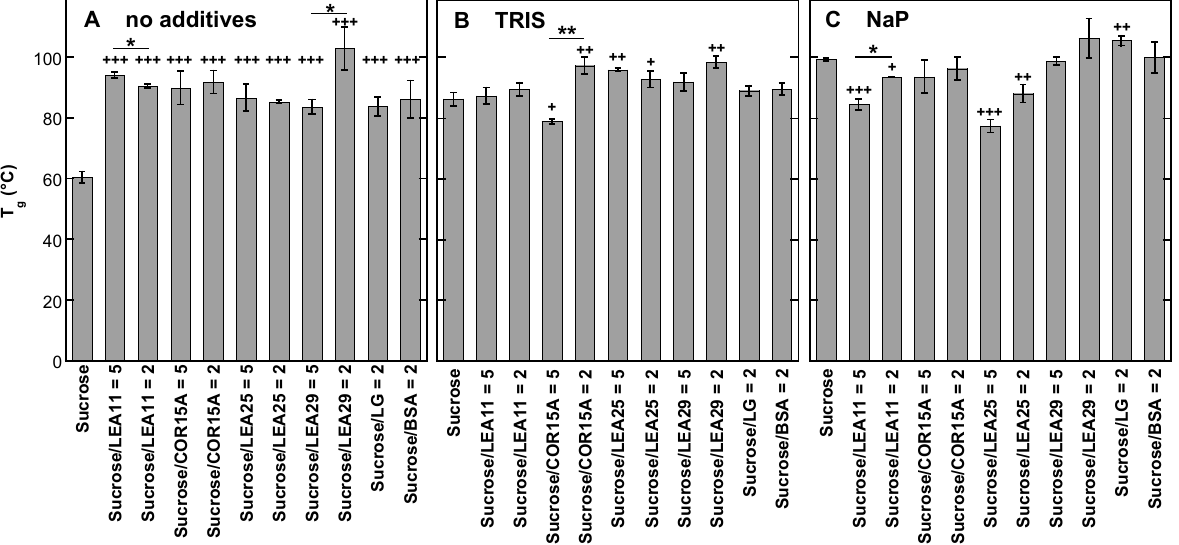
Figure 5. Glass transition temperature (T g ) of dry Suc. Samples contained either pure Suc or, in addition, the proteins LEA11, COR15A, LEA25, LEA29, β -lactoglobulin (LG) or bovine serum albumin (BSA). All solutions contained 10 mg/mL Suc and were prepared in H 2 O ( A ), 10 mM Tris ( B ) or 10 mM NaP buffer (pH 7.4) ( C ). In addition, samples contained proteins at the indicated Suc/protein mass ratios. Samples were dried on CaF 2 windows. The bars indicate the means from at least three samples ± standard deviation. Statistically significant differences between the values determined at the two different Suc/LEA mass ratios are indicated by *, while significant differences between the values obtained in the presence of the different proteins and pure Suc are indicated by + (*, + ˂ 0.05; **, ++ ˂ 0.01, +++ ˂ 0.001).